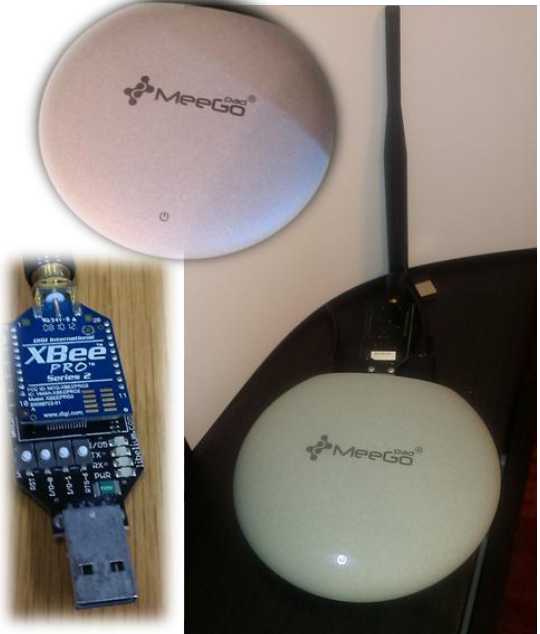
Figure 13. Infrastructure’s hardware, including XBee Pro ZigBee Motes and MeeGo Mini PC sink device.